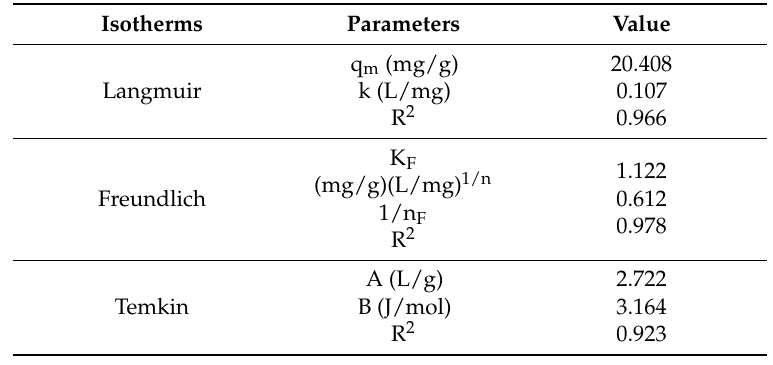
Table 2. Isotherm parameters of the three models, Langmuir, Freundlich and Temkin, for phenol removal on to magnetic ZnO